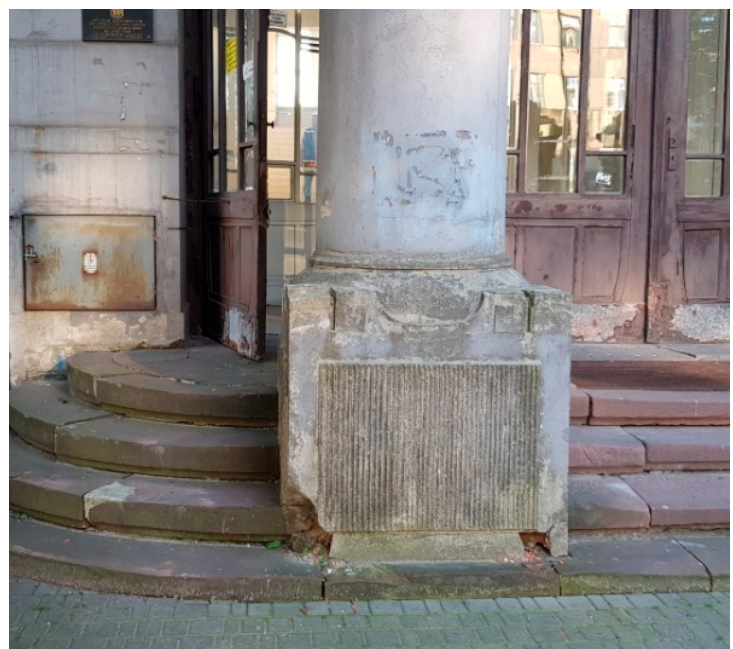
Figure 9. Damage and cavities in exterior stairs made of red